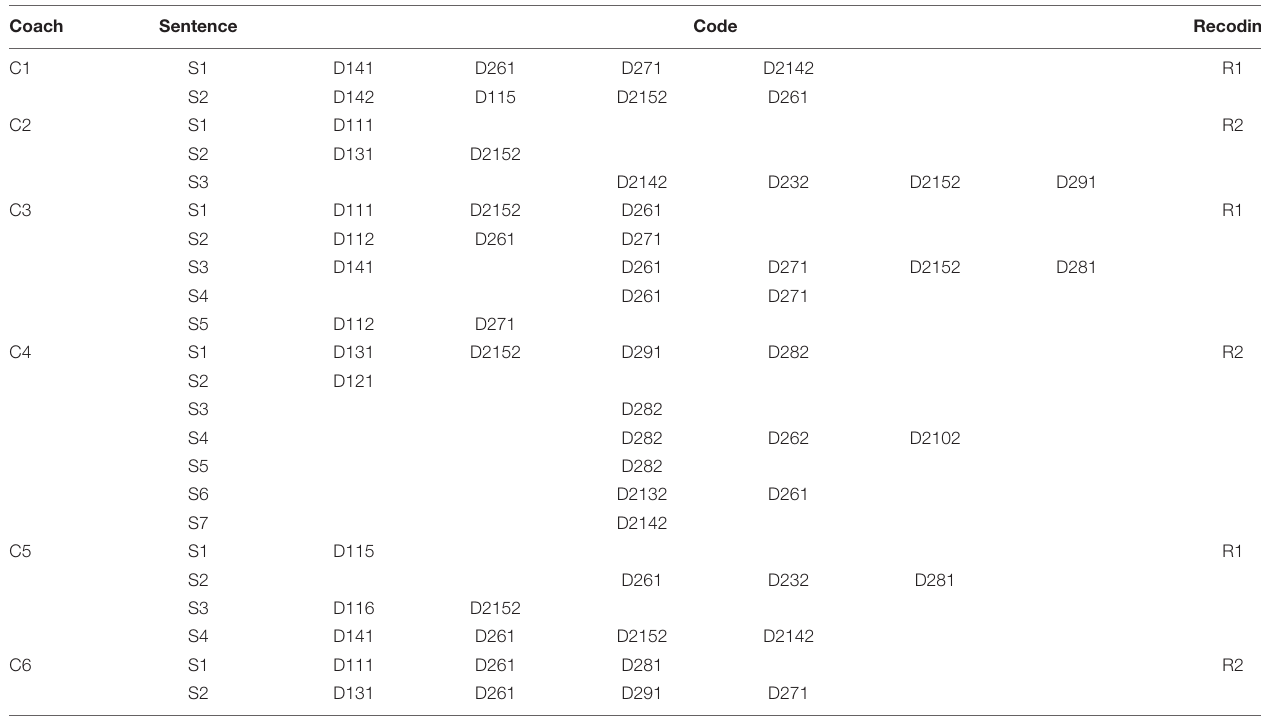
TABLE 3 | Example of code matrix related to question